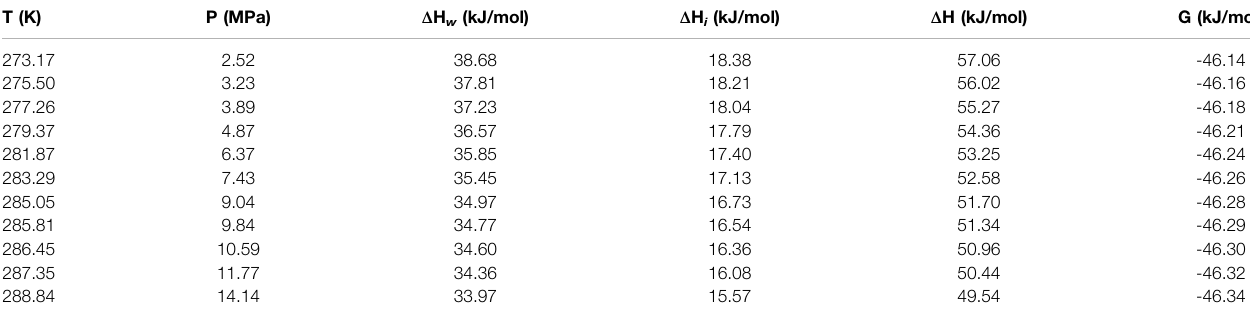
TABLE 1 | Data of methane hydrate phase transition (partial).